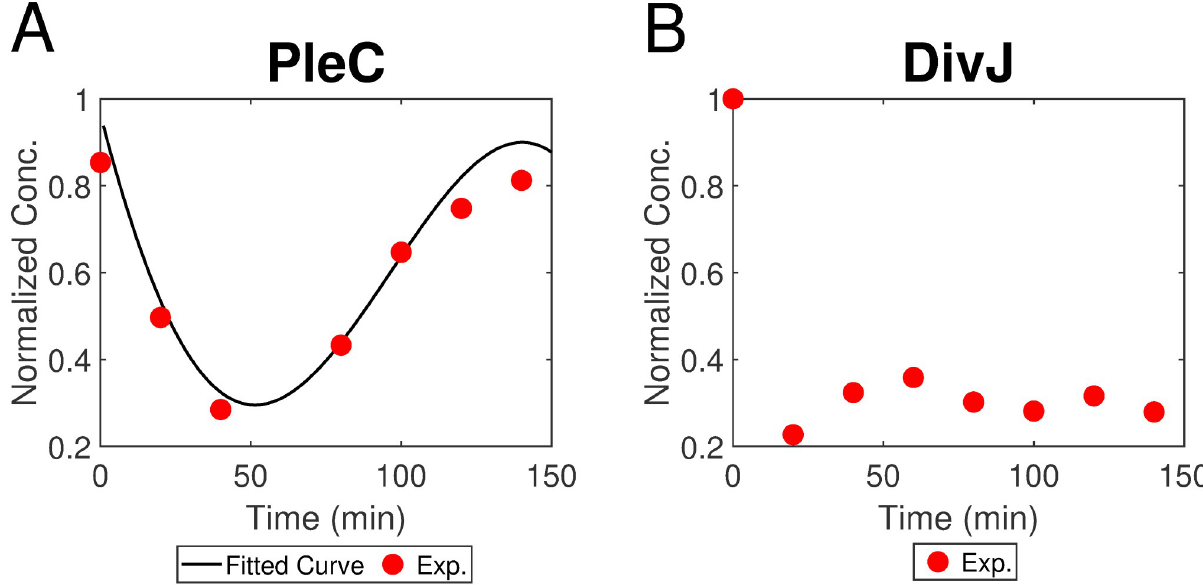
Fig 6. Quantification of experimental data of PleC from [35] and DivJ from [36]. (A) Black curve is fitted from experimental data by MATLAB. The fitting function is 80.09 × sin(0.013 t + 1.74) + 78.77 × sin(0.013 t + 4.85). (B) Experimental data of DivJ indicates DivJ levels sharply drop during the sw- to-st transition and then almost do not